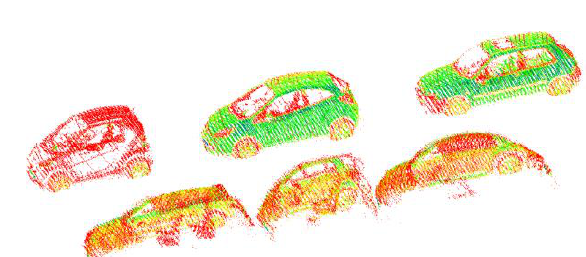
Figure 3. Visualization of the dispersion of the reflectance values of cars (ranging from 55 to 255); the colours range from dark green (lowest) to yellow, red and brown (highest).